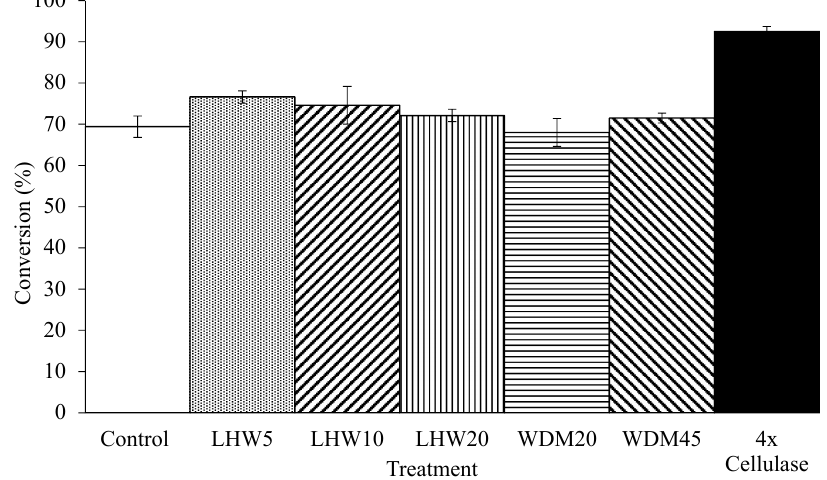
Figure 4. Conversion of fiber into ethanol achieved with different pretreatments.